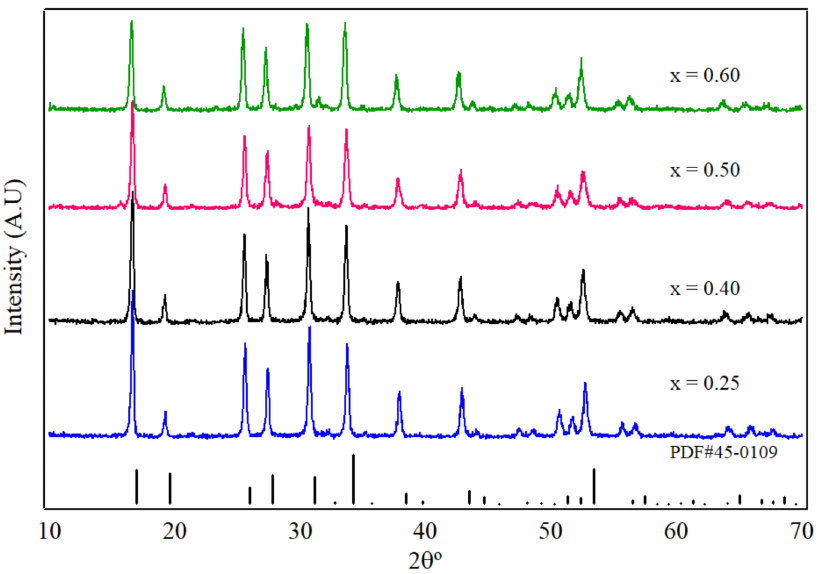
Figure 1. XRD patterns of Li 5+2x La 3 Nb 2 − x Sm x O 12 garnets with x = 0.0.25—0.6